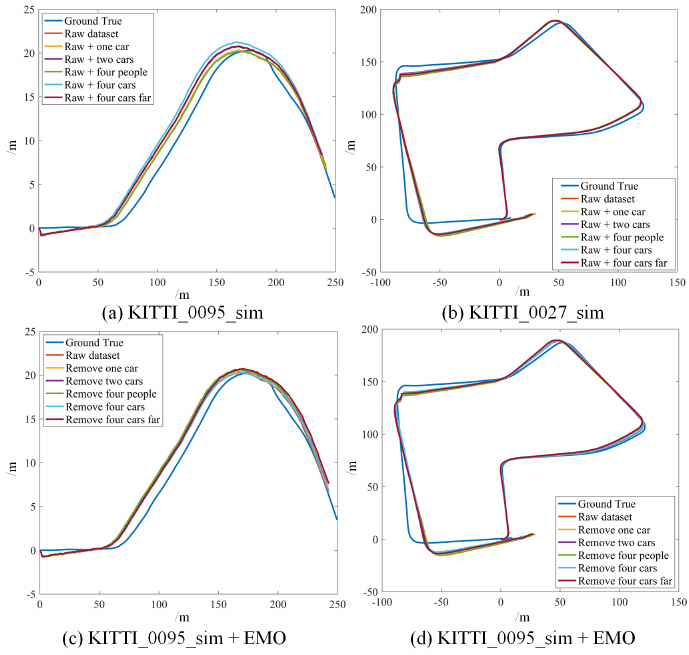
Figure 14. The odometry results of [Cartographer] ( a , b ) and [Cartographer + EMO] ( c , d ) based on KITTI_0095_sim and KITTI_0027_sim. After removing the moving objects with our method, it yields evidently improved odometry accuracy in all the